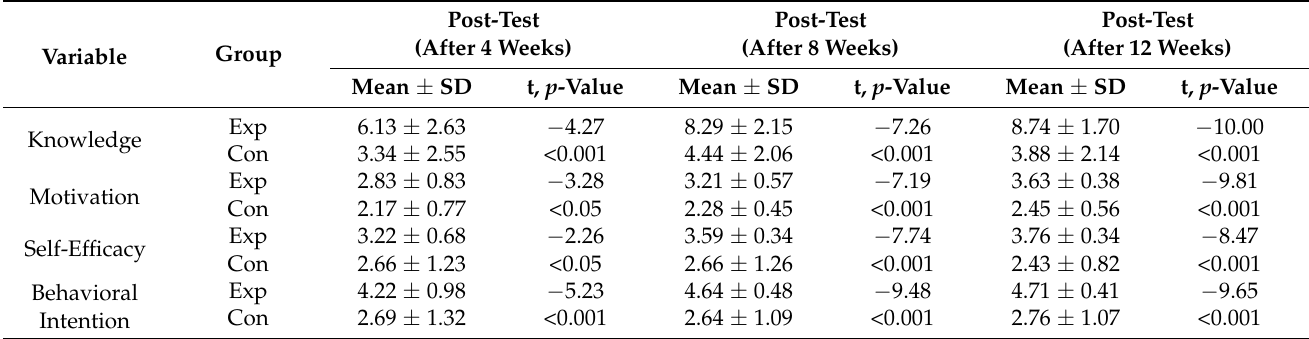
Table 6. Outcome variables in the experimental and control group (n =